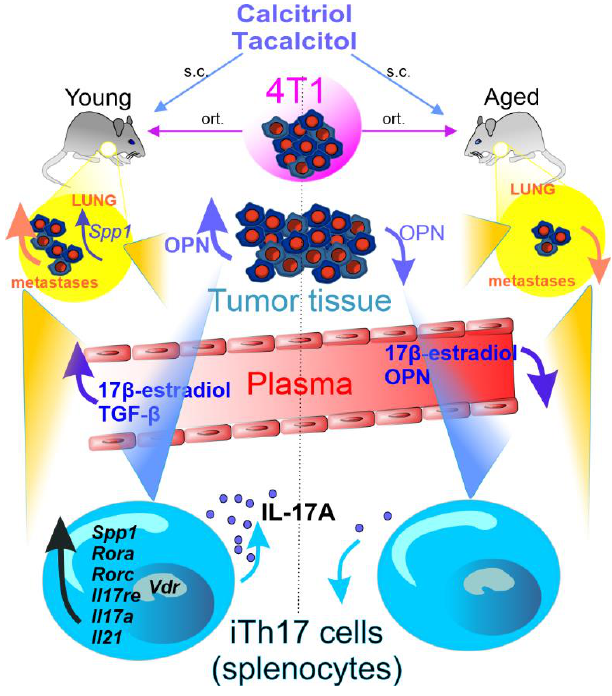
Figure 7. The effect of calcitriol or its analogs on Th17 cells in young and aged mammary gland tumor-bearing mice. Young (~8 weeks old) or aged ovariectomized (~50 weeks old) BALB/c mice were transplanted orthotopically (ort.) with 4T1 mouse mammary gland cancer cells, and then injected s.c. with calcitriol or tacalcitol. Increased metastatic potential was observed in young mice treated with calcitriol or tacalcitol, whereas in aged mice decreased metastasis count was noticed. In young mice, lung tissue showed increased osteopontin gene ( Spp1 ) expression with increased osteopontin (OPN) protein level and plasma level of 17β -estradiol and TGF- β, which may contribute to increased Th17 cell differentiation and increased metastatic spread of 4T1 tumors. In aged mice, OPN level in tumor tissue, as well as plasma level of OPN and 17β -estradiol, was decreased with lower IL-17A production by induced Th17 cells (iTh17), leading to decreased metastatic potential of 4T1 cells.